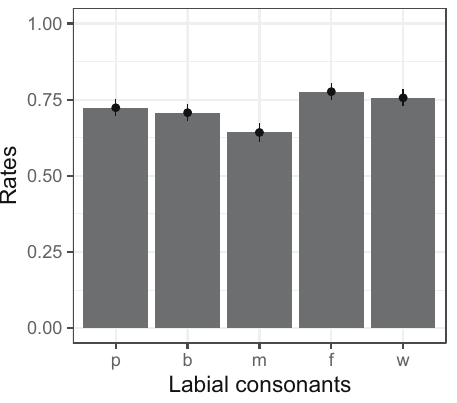
Figure 2: Rates of selecting names with labial consonants for a “ cute ” name ( Japanese )